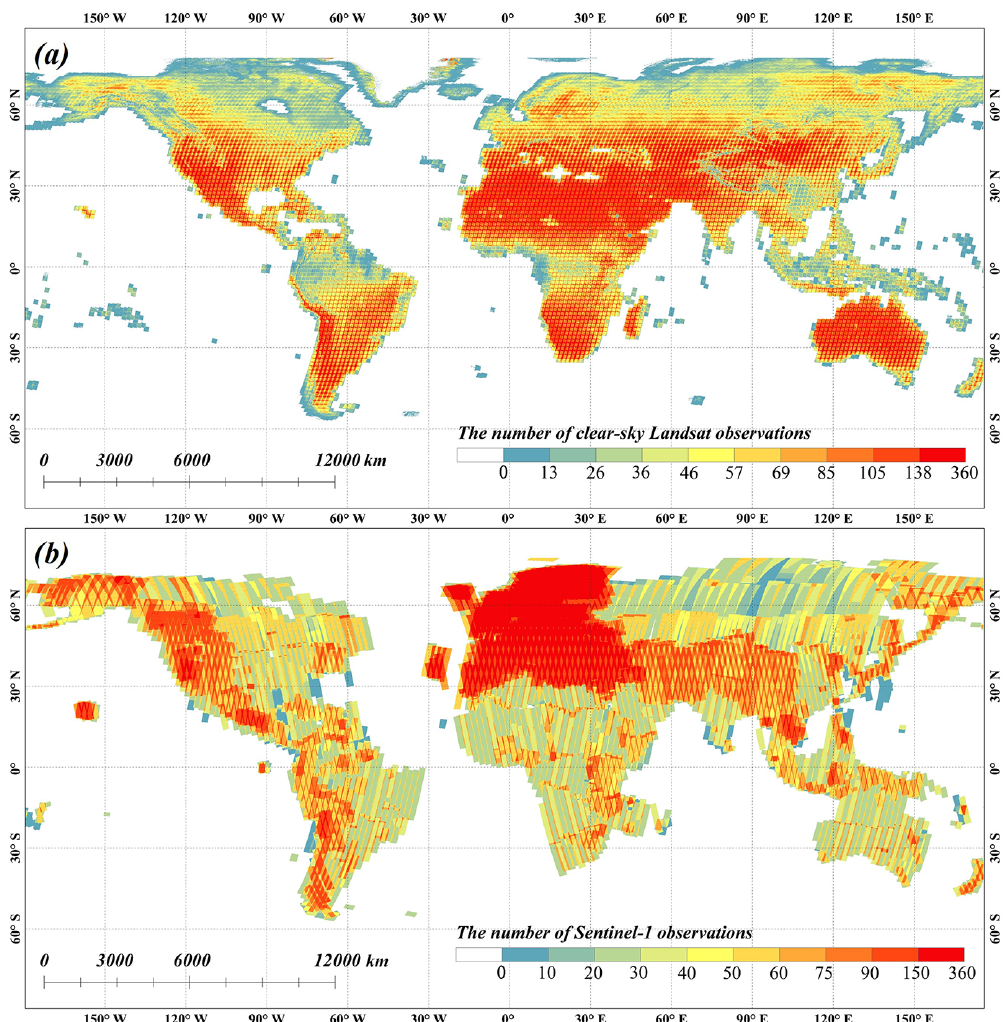
Figure 1. The spatial distribution of clear observations after masking these “poor-quality” observations during 2019–2021 (a) and availability of Sentinel-1 SAR time-series observations in 2020 (b)